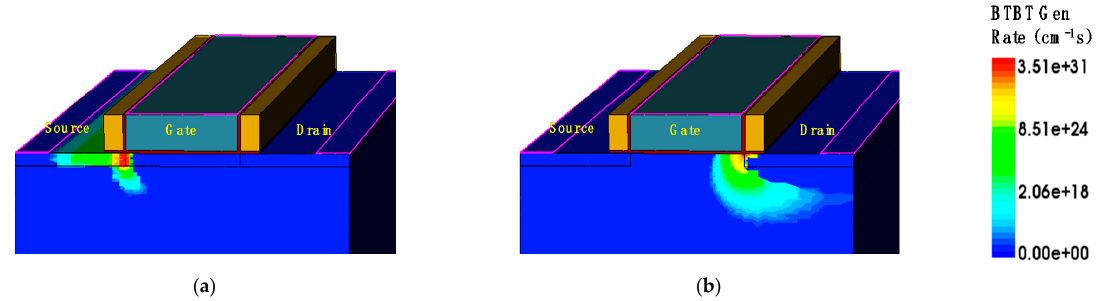
Figure 4. Band ‐ to ‐ band tunneling gen rate (G BTBT ) distribution of ( a ) PNN TFET and ( b ) Conventional TFET at source/channel junction.